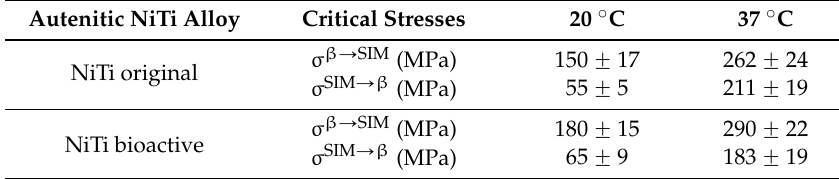
Table 4. Critical stresses at different test temperatures for austenitic NiTi alloy.